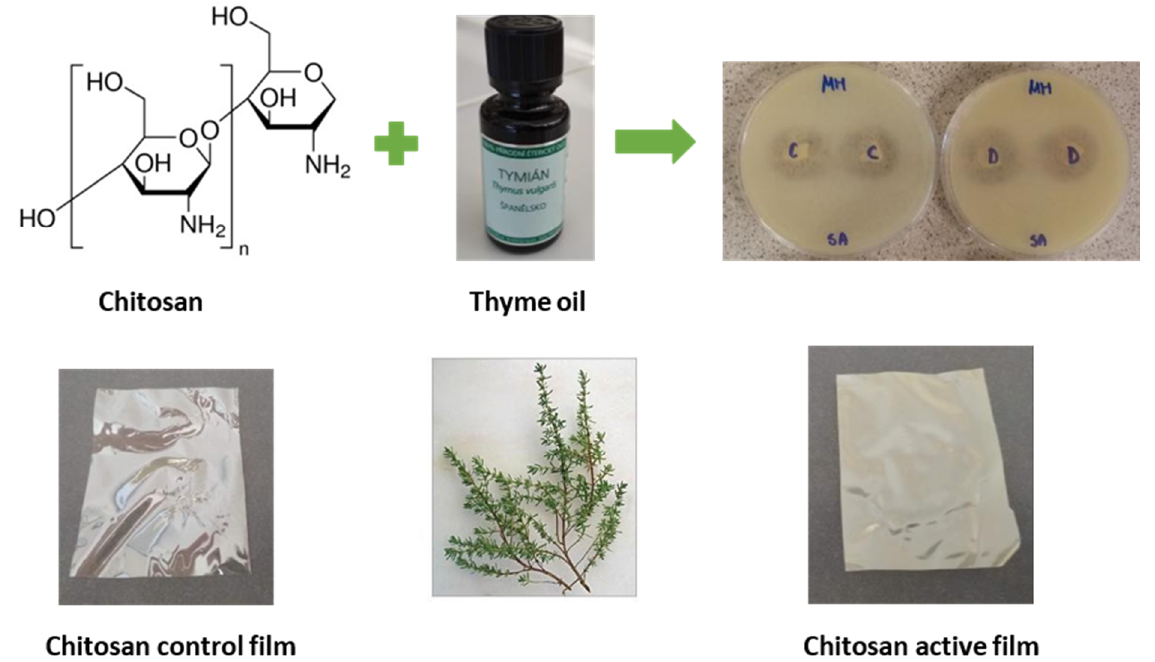
Figure 18. Schematic representation of the development of natural extract-containing edible food coatings (taken from [34] under Creative Commons